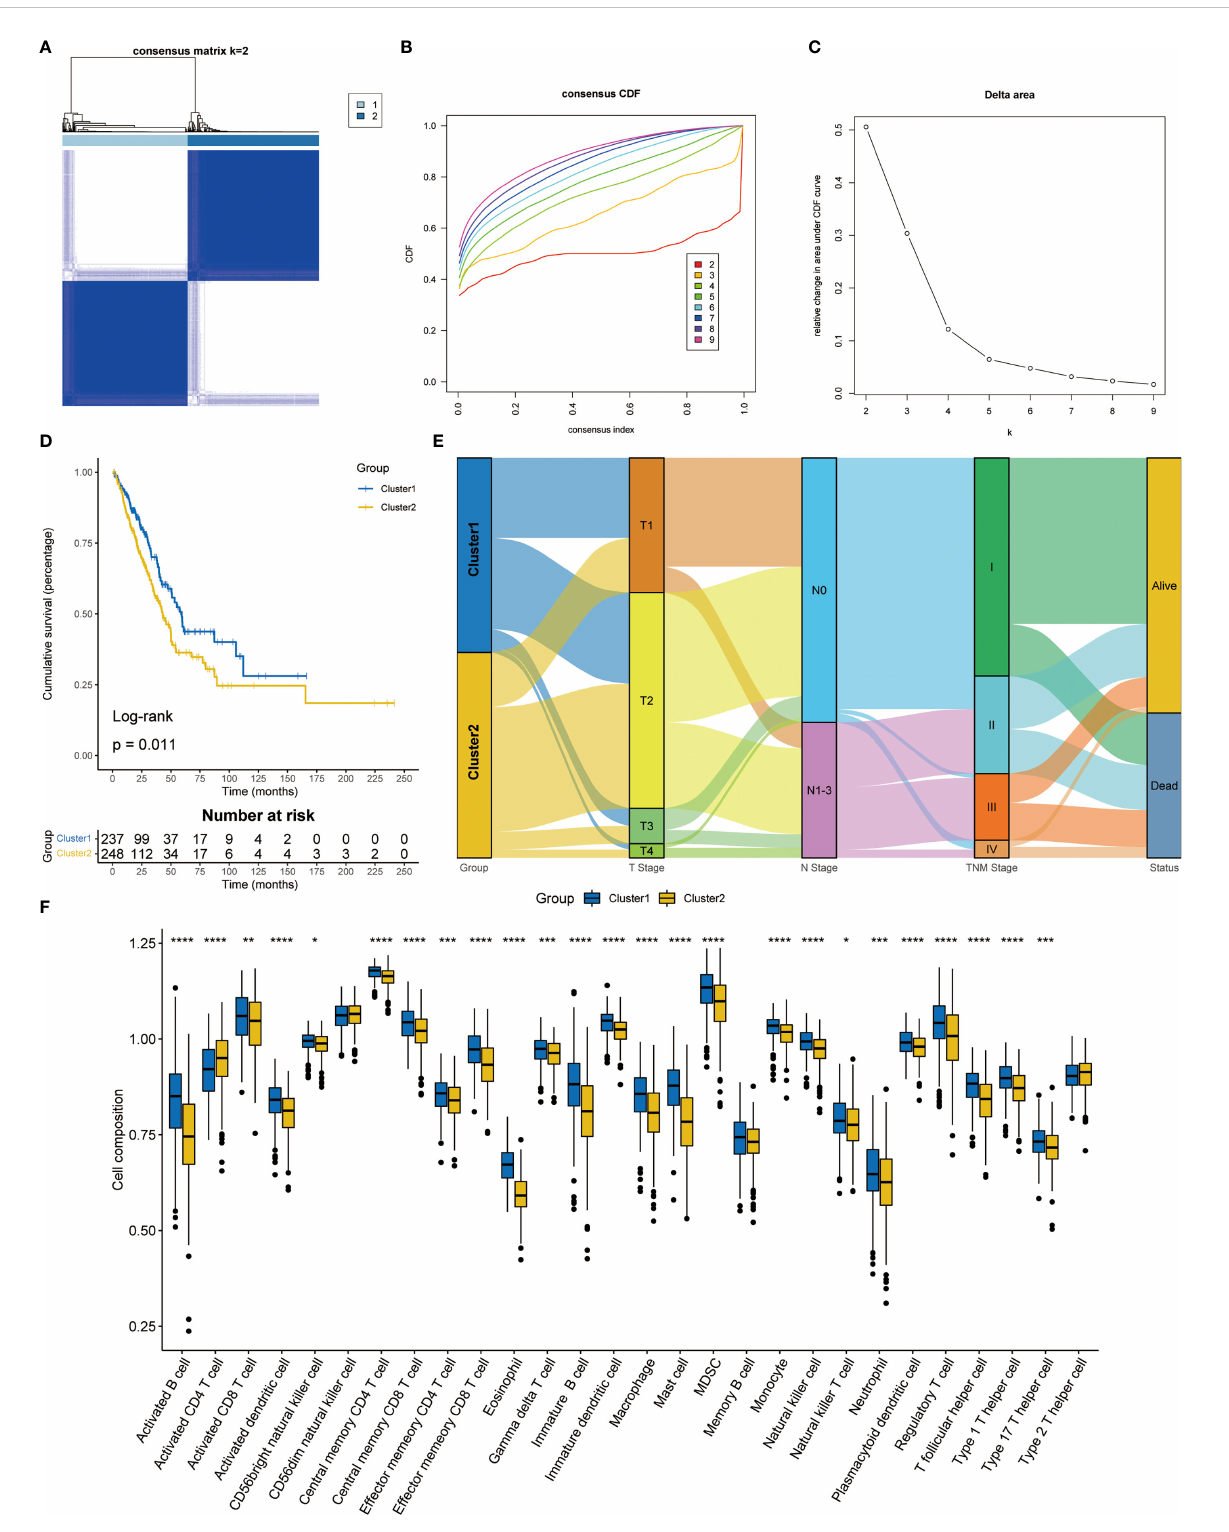
FIGURE 2 Consensus clustering analysis based on T cell proliferation regulators. (A) Consensus clustering matrix at k = 2. (B) The CDF curves for clusters from k = 2 to 9. (C) The relative change in the area under the CDF curve from k = 2 to 9. (D) Kaplan-Meier survival analysis between two clusters. (E) Sankey diagram showed the relationship between TNM stage and two clusters. (F) The proportion of 28 kinds of immune cells in two clusters. *p < 0.05, **p < 0.01, ***p < 0.001, ****p <